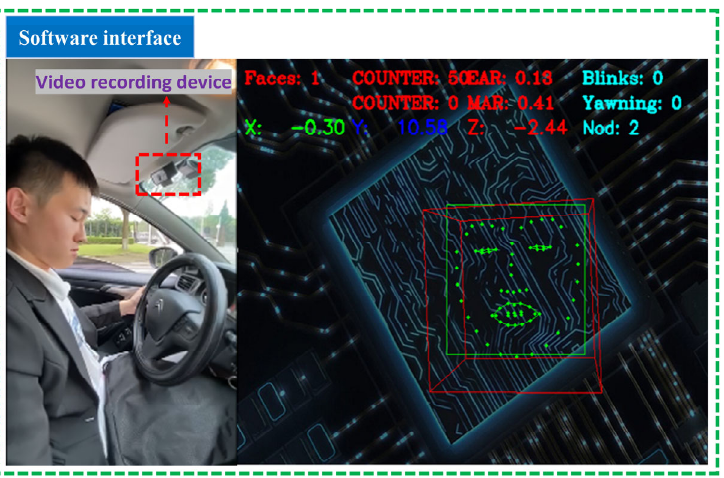
Figure 1. Fatigue driving detection software interface.